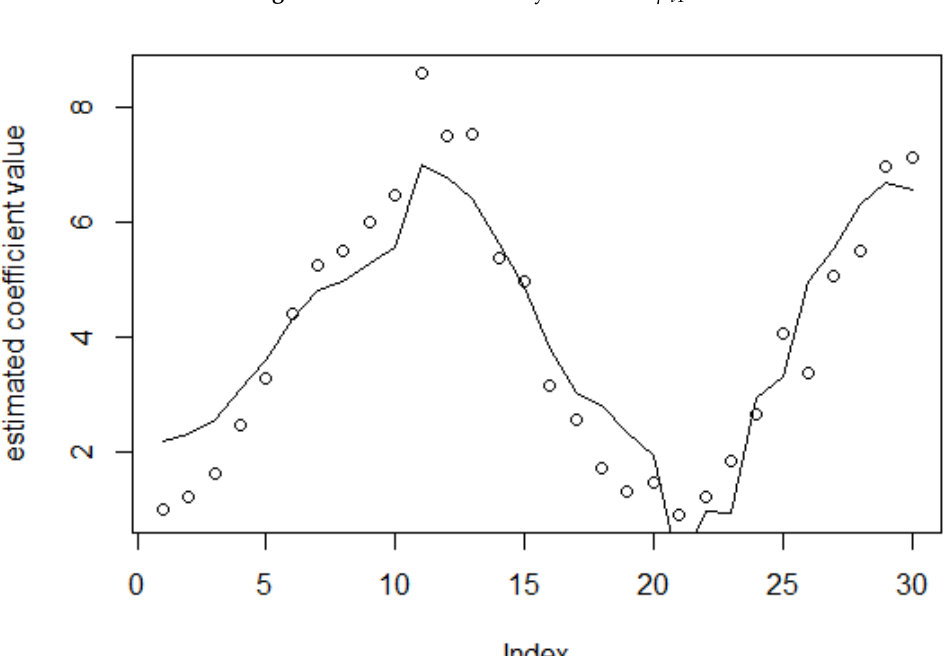
Figure 4. Coefficient value dynamics for 𝛽 𝑡1 .